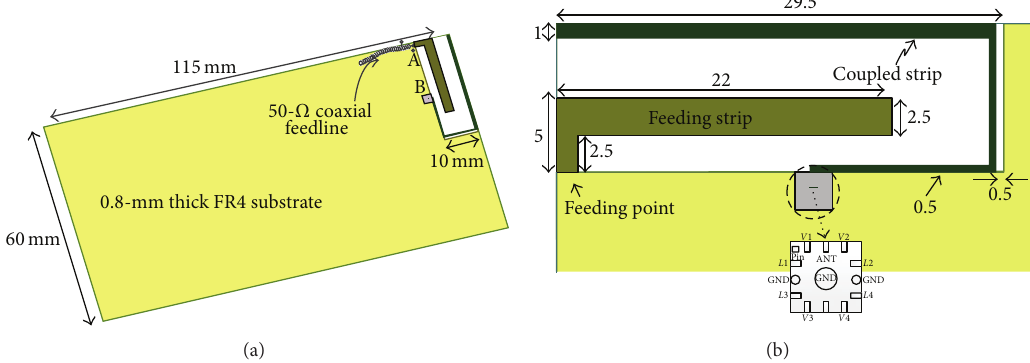
Figure 1: Proposed reconfigurable antenna configuration. (a) Geometry of the frequency reconfigurable antenna. (b) Detailed dimensions of the reconfigurable antenna ( 𝐿1 = 6.8 nH; 𝐿2 = 9.2 nH; 𝐿3 = 15 nH; 𝐿4 = 17 nH; GND: ground point). All dimensions are in millimeters.